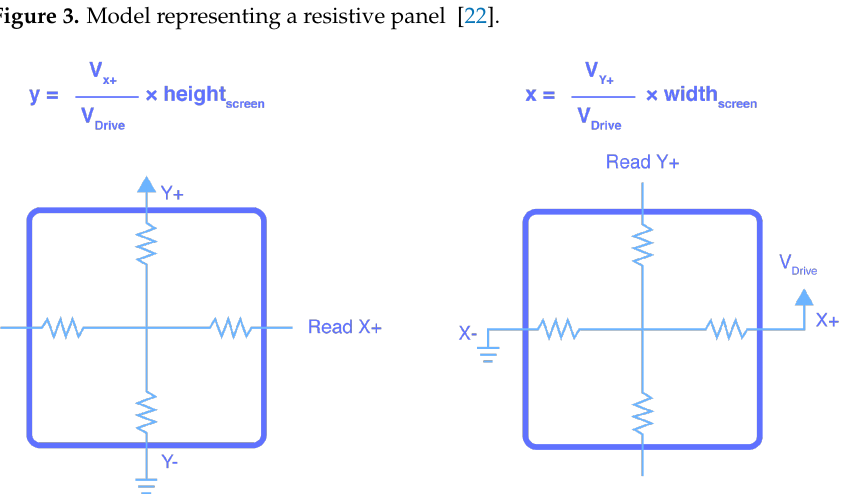
Figure 4. Electrical models of a resistive sensor